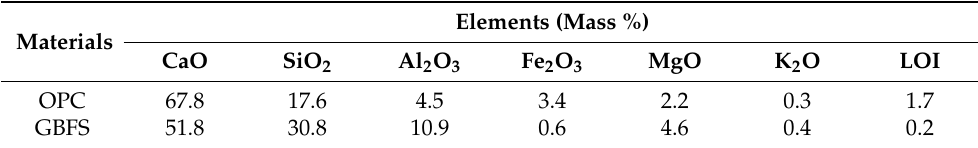
Table 1. The chemical compositions of the OPC and GBFS obtained from the XRF analyses.